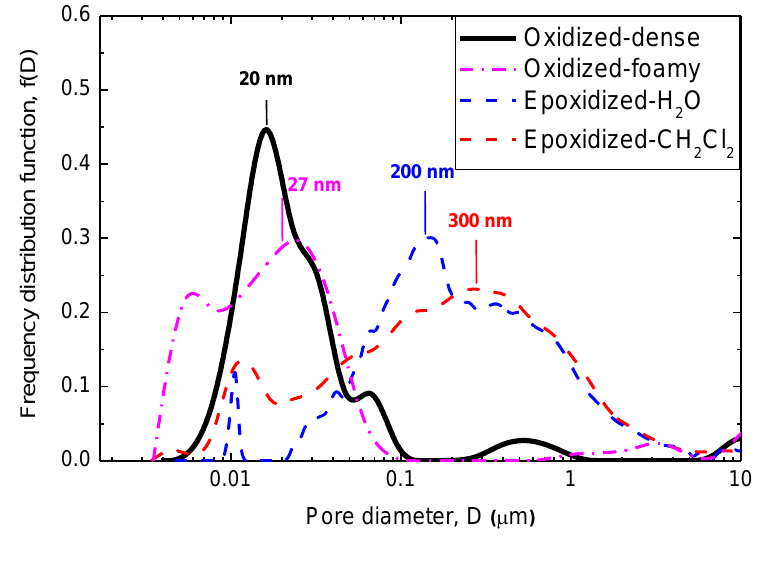
Figure 4. ( a ) SEM photo of an oxidized buckypaper; ( b ) SEM photo of an epoxidized